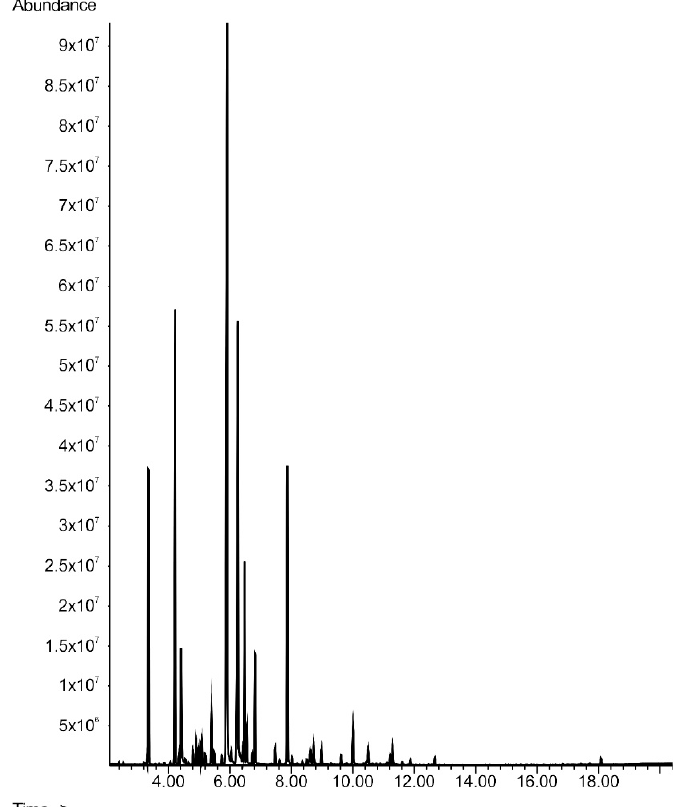
Figure A3. The gas chromatogram of the geranium commercial oil. Dilution 1:40 ( v / v ) in dichloromethane.